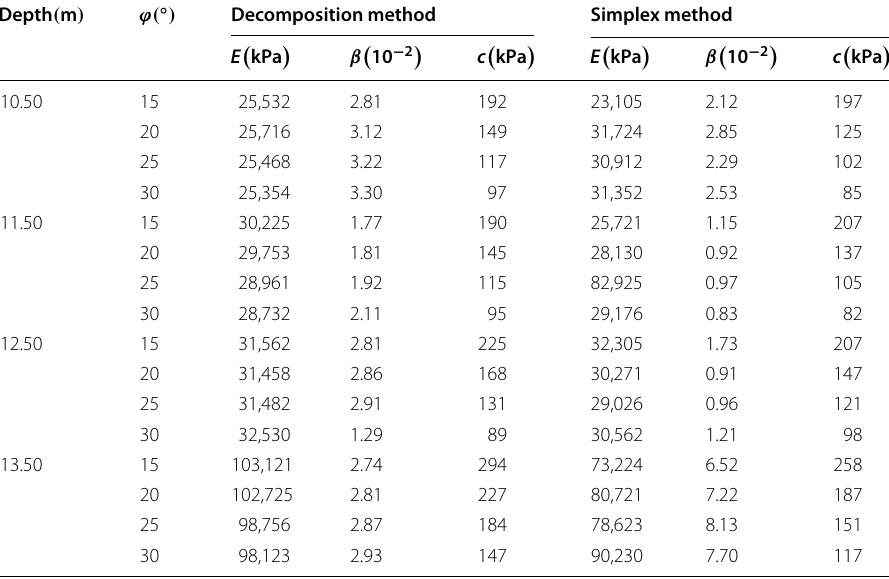
Table 2 Simulation results for various values of φ at different depths Depth ( m